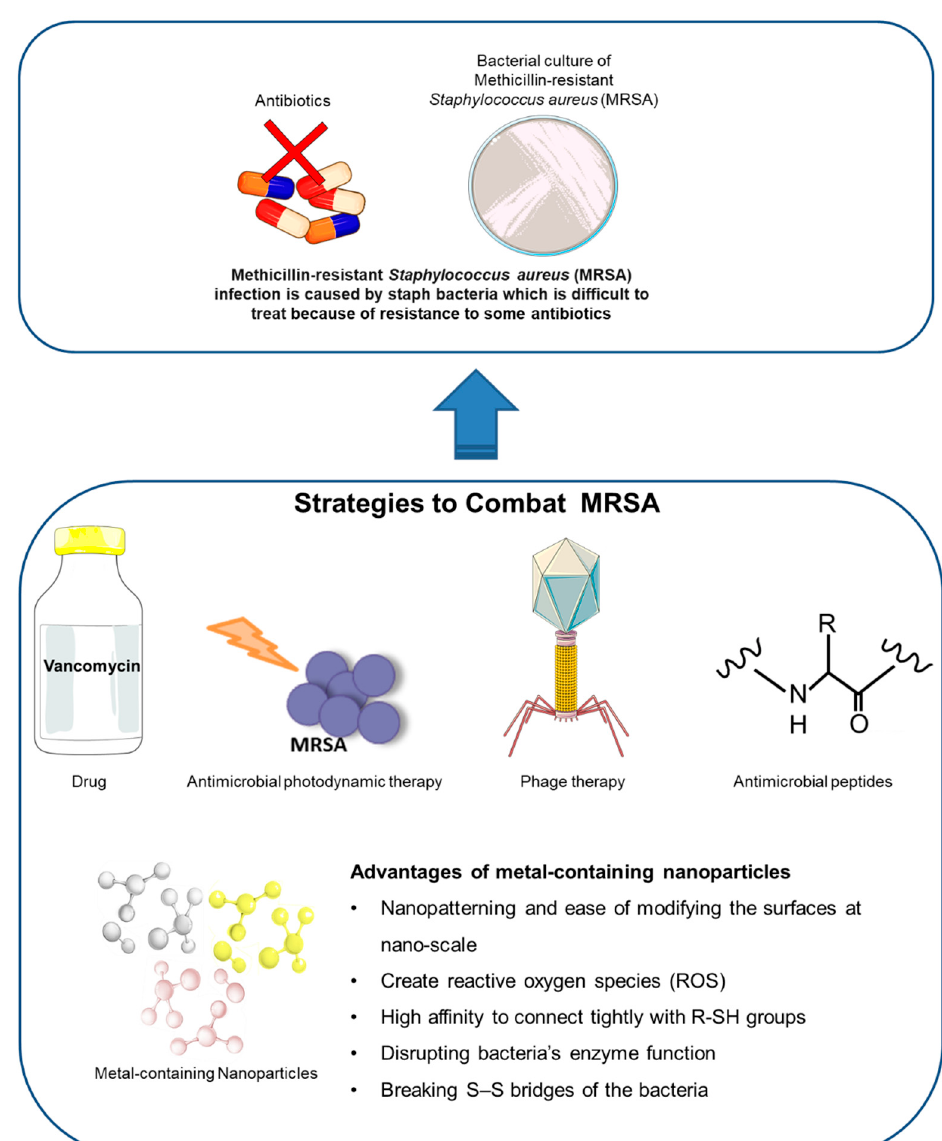
Figure 1. Emerging of metal-containing NP as an alternative strategy used to combat MRSA. Figure was modified using Servier Medical Art templates, which are licensed under a Creative Commons Attribution 3.0 Unported License (https://creativecommons.org/licenses/by/3.0/) [Accessed on 10 June 2022]. Table 1. Summary of metal NP discussed in the present study. Metal Nanoparticles Findings